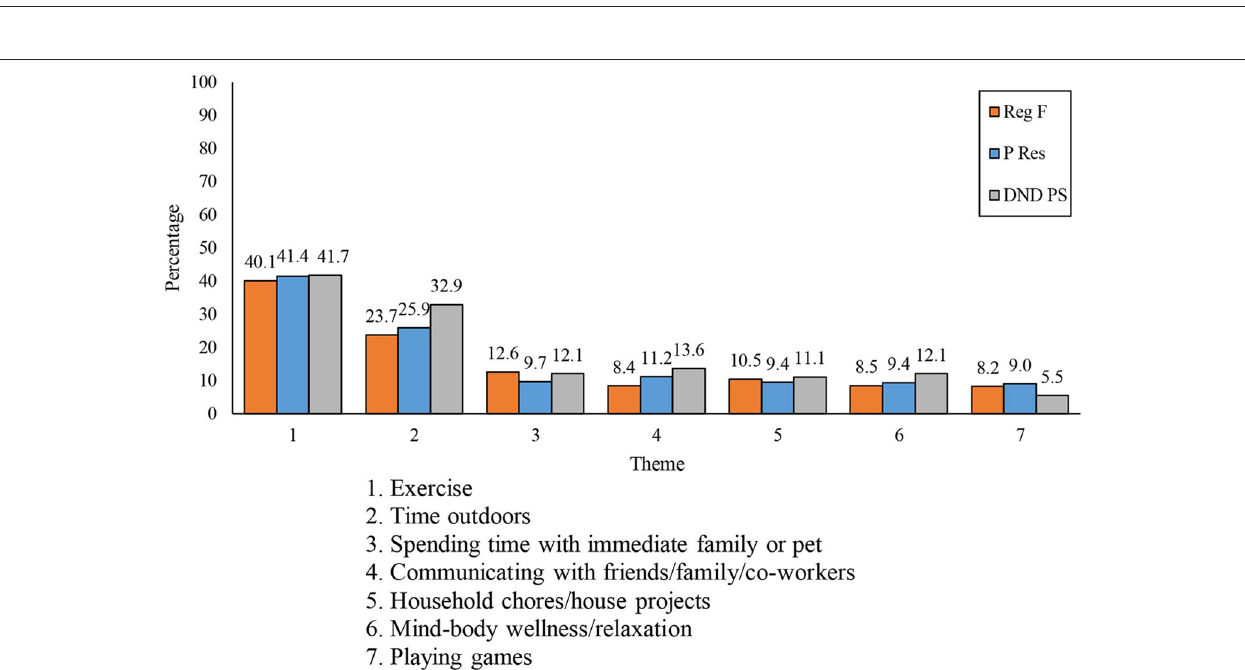
FIGURE 6 | Seven most frequently mentioned coping strategies among each